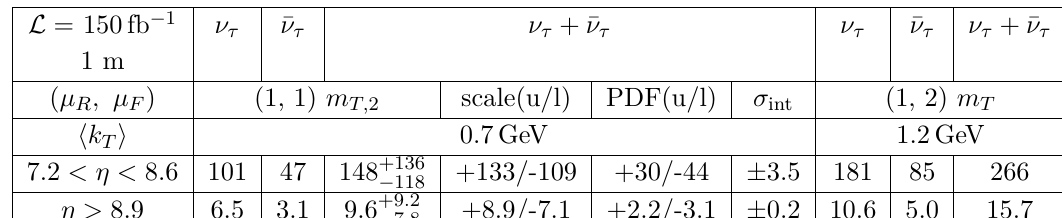
Table 2. The numbers of events induced at different pseudorapidities in 1 m length of tungsten by the CC interactions of ν τ and ¯ ν τ arising from the decay of D ± √ at s = 14 TeV for an integrated luminosity L = 150 fb − 1